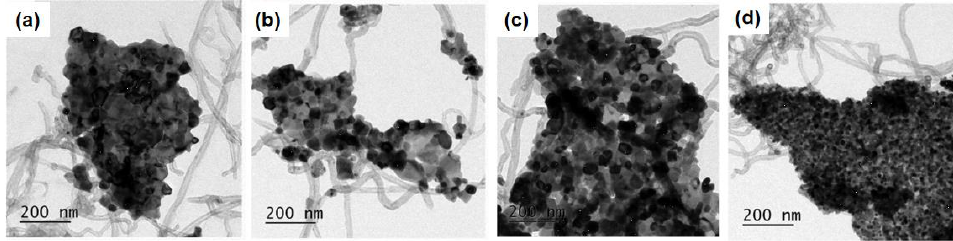
Figure 7. Bright field TEM images ( a – d )